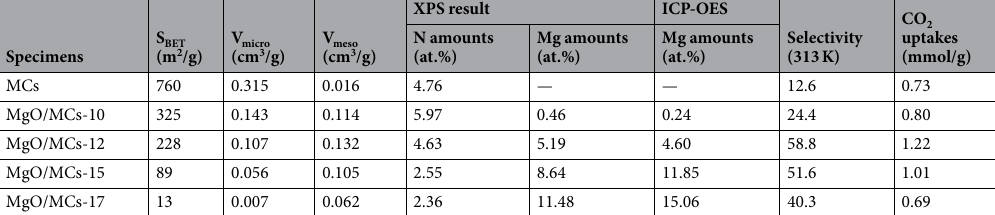
Table 1. Textural properties and Mg loading amounts of the prepared MgO/MCs samples. Micropore volume and mesopore volume were determined using Dubinin–Radushkevich (D–R) equation and Barrett–Joyner– Halenda (BJH) model, respectively. Mg and N amounts were measured by XPS and ICP-OES analysis. CO 2 /N 2 selectivity was calculated by Henry’s law constant using virial equation. CO 2 uptakes were investigated at flue gas condition (313 K, 15% CO 2 /85% N 2 , 1